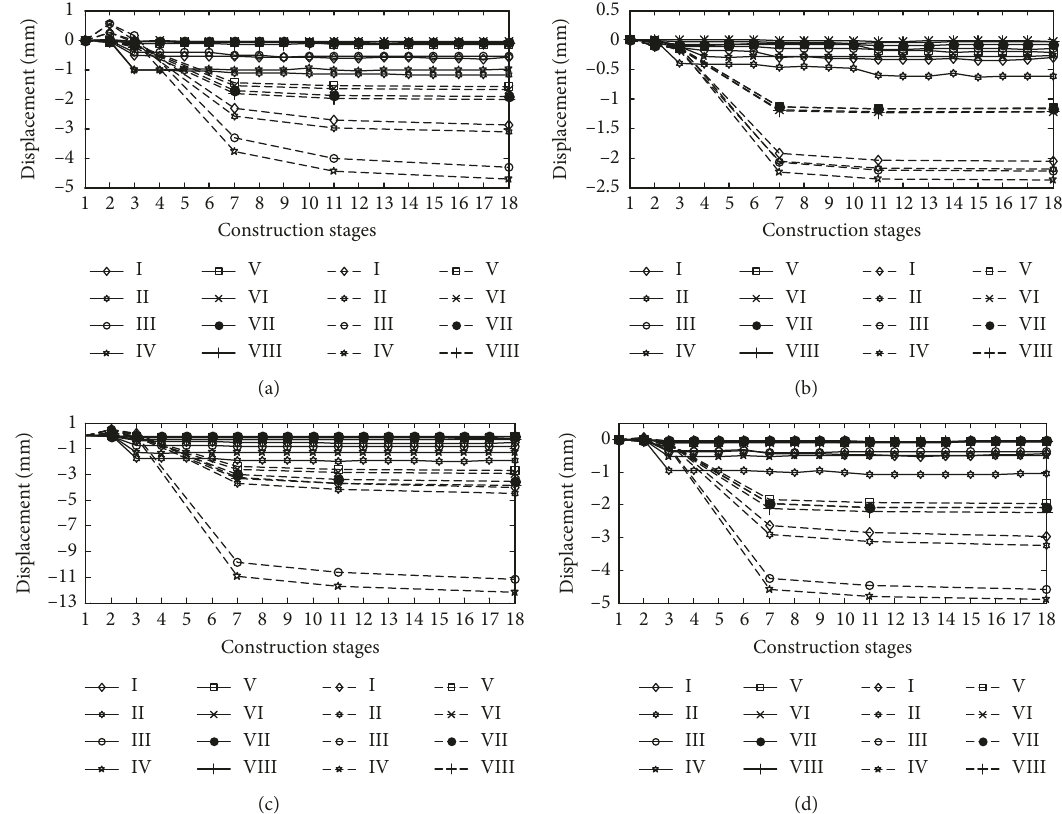
Figure 22: Comparison of horizontal displacement of existing buildings between experimental and numerical results: (a) the top of left building; (b) the bottom of left building; (c) the top of right building; (d) the bottom of right